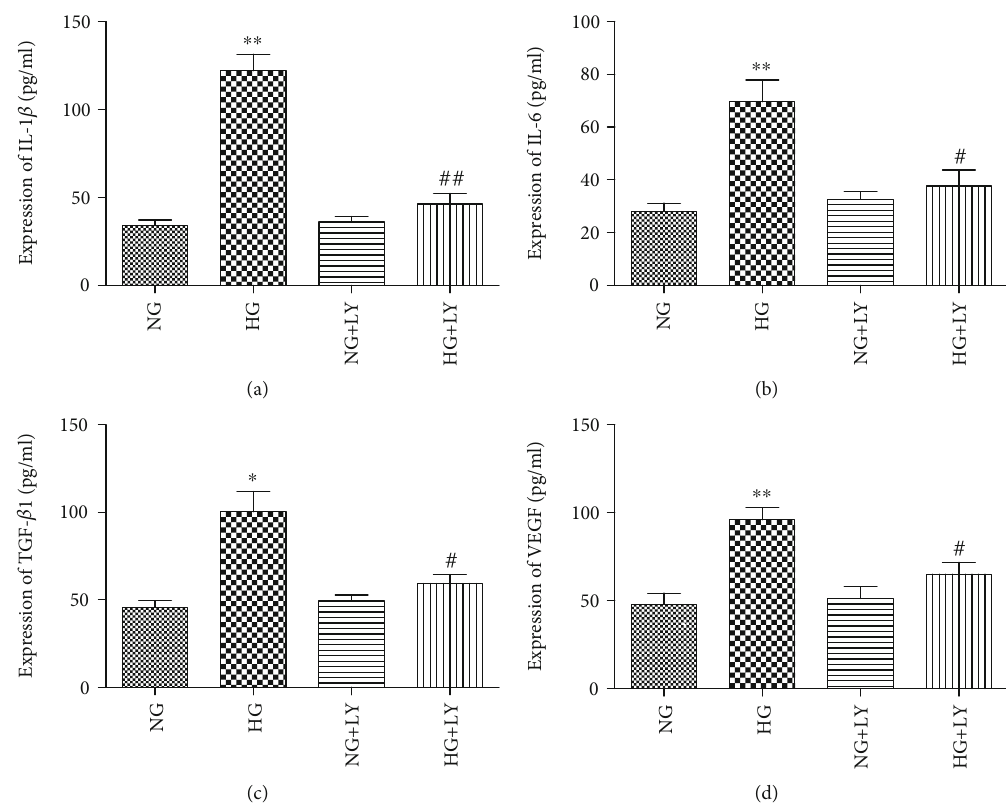
Figure 7: The PI3K/Akt signalling pathway mediated the protein level of IL-1 β , IL-6, TGF- β 1, and VEGF in RPE cells under high-glucose conditions. RPE cells were preincubated for 1 h with 10 μ M of LY294002 and then stimulated by HG (30 mM) for 24h. The IL-1 β , IL-6, TGF- β 1, and VEGF protein levels were determined using the ELISA kit. LY294002 signi fi cantly decreased the HG-induced protein (a – d) levels of IL-1 β , IL-6, TGF- β 1, and VEGF in RPE cells. The data shown represent the mean ± SD of three independent experiments. ∗ p < 0 : 05 versus NG; ∗∗ p < 0 : 01 versus NG; # p < 0 : 05 versus HG; ## p < 0 : 01 versus HG. LY: